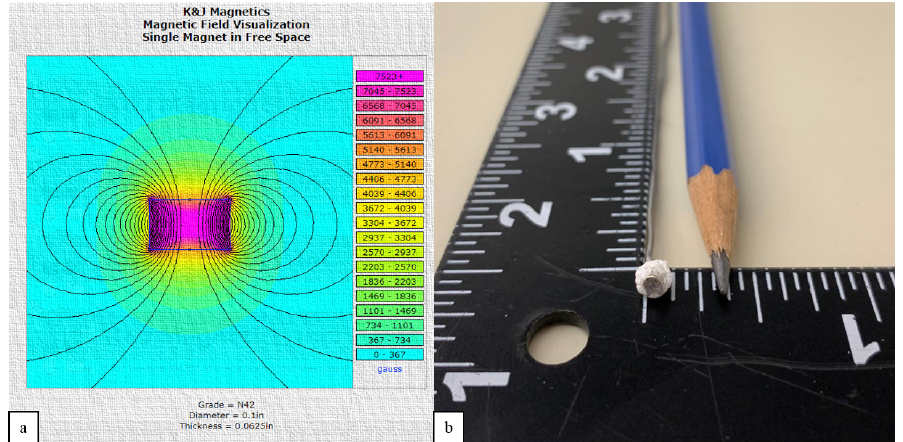
Figure 18. The agent’s dimensions ( a ) and properties from the manufacturer [41] ( b ) with the attached flexible part in inch.